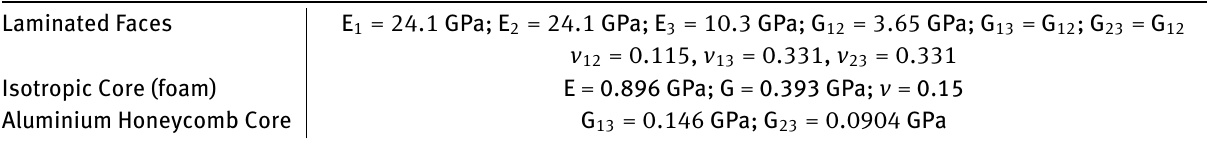
Table 2: Material properties of sandwich cylindrical panels * Laminated